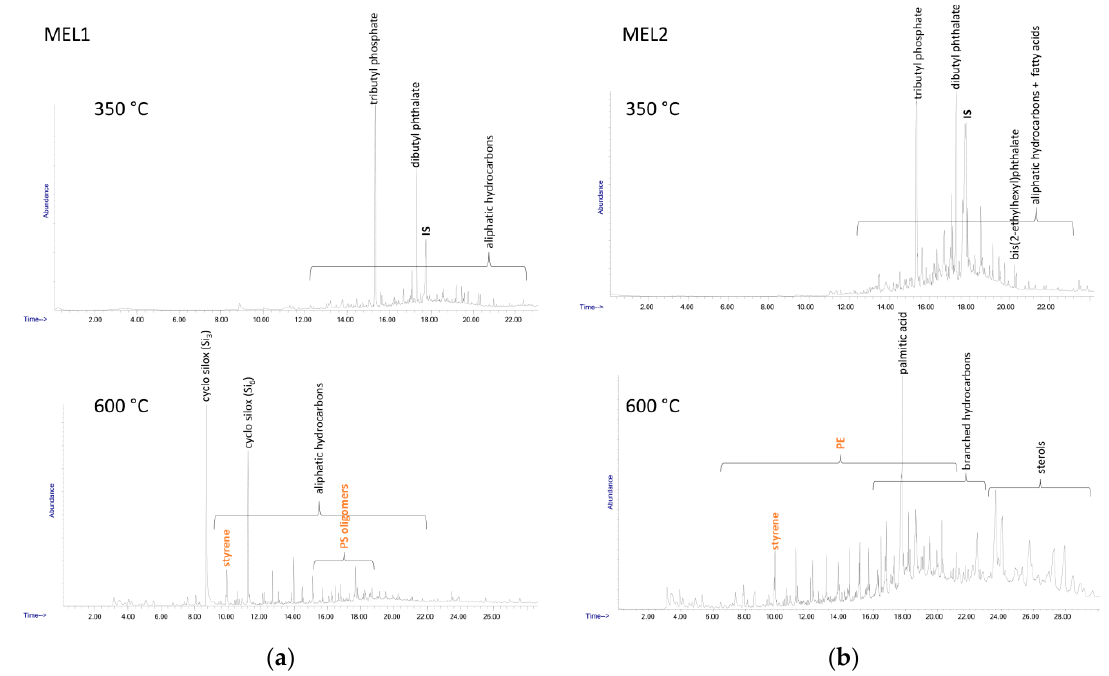
Figure 6. Py-GC-MS chromatograms of sediment DCM extracts: ( a ) MEL1; ( b ) MEL2.